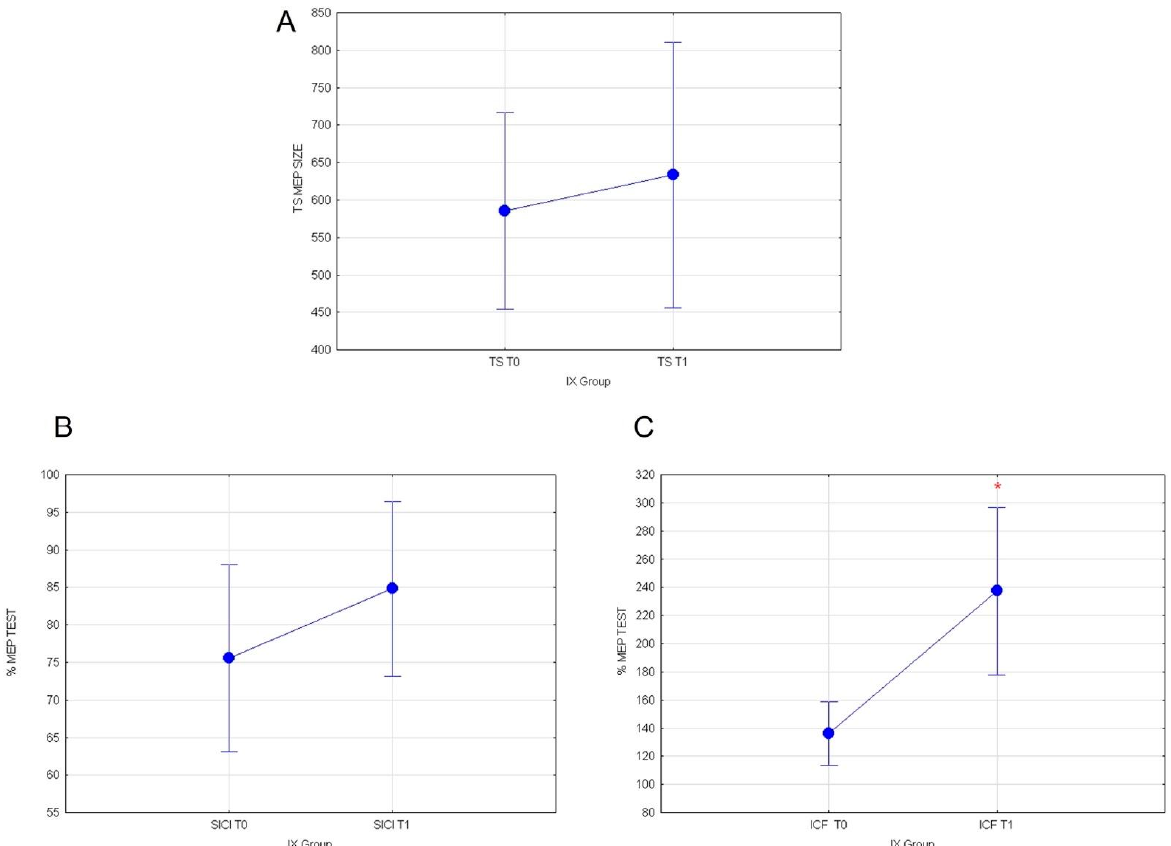
Figure 3. ( A ) MEP values for TEST stimulus, ( B ) normalized % MEP for SICI, and ( C ) normalized % MEP for ICF, at T0 vs. T1 for IX group are shown. Vertical bars denote 0.95 confidence intervals. (*) for p < 0.05.